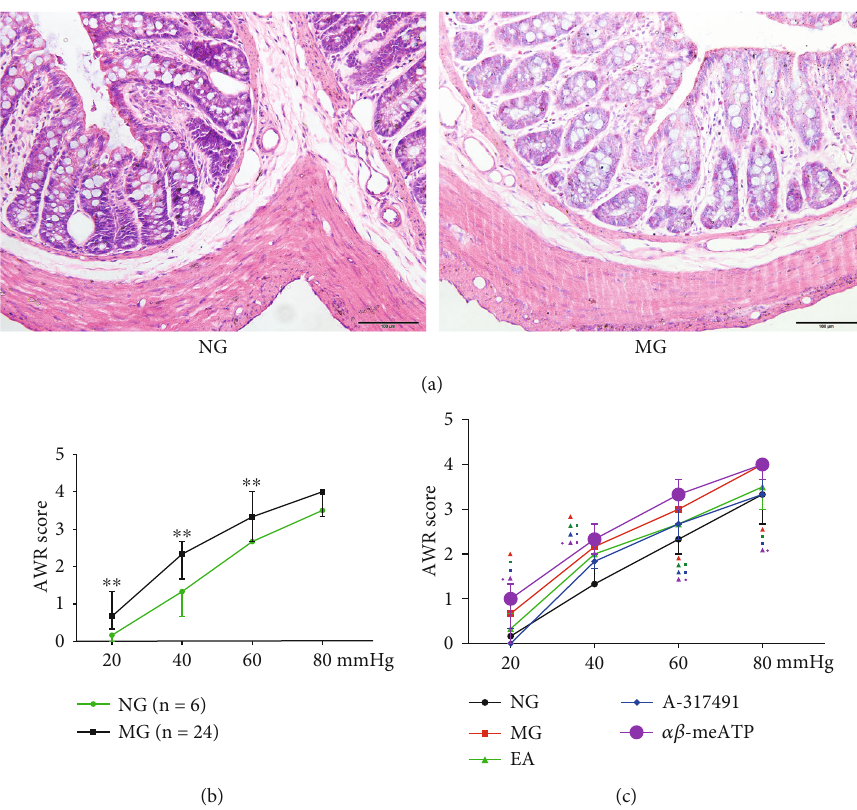
Figure 1: HE staining of colon tissue and AWR scores. (a) HE staining of colon tissue ( scalebar = 100 μ m ); (b) Behavioral scores before EA and drug intervention (NG: n = 6 ; MG: n = 24 ). ∗∗ P < 0 : 01 vs. NG. (c) Behavioral scores after EA and drug intervention ( n = 6 ). ▲ P < 0 : 05 vs. NG; ▪ P < 0 : 05 vs. MG; ♦ P < 0 : 05 vs.